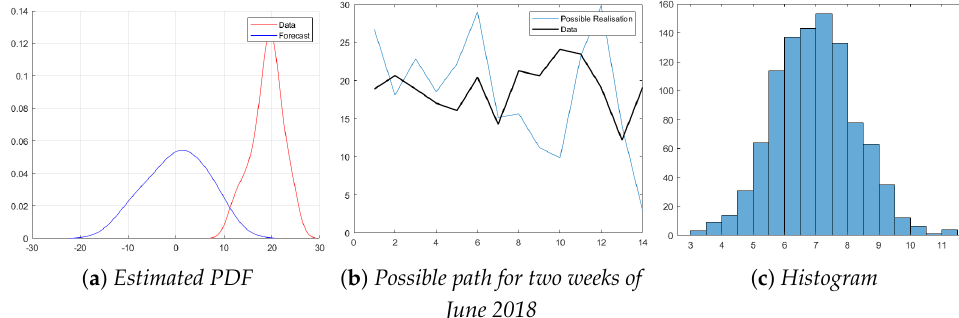
Figure 15. Summary of results for spring/summer period.